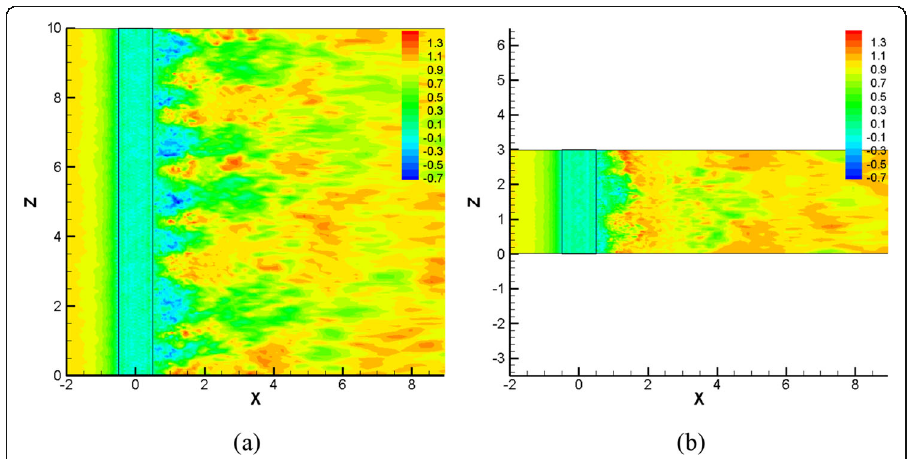
Fig. 2 Contours of dimensionless instantaneous stream-wise velocity of (a) AR = 10 and (b) AR = 3